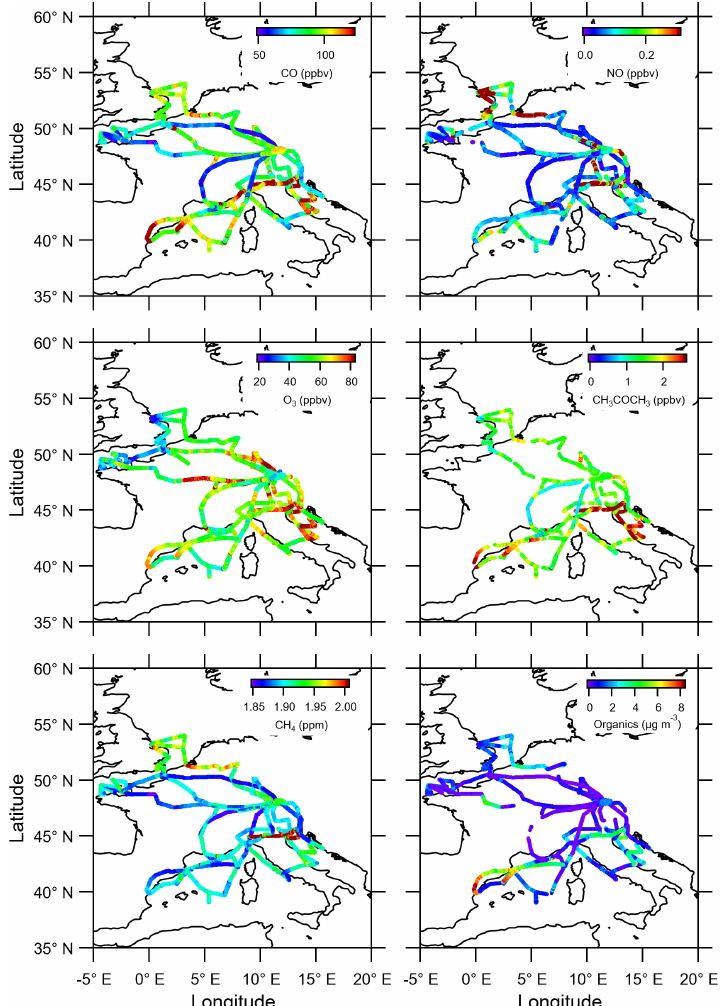
Figure 11. Mixing ratios of CO NO, O 3 , CH 3 COCH 3 , CH 4 , and organic aerosol mass concentrations measured along all EMeRGe flights in Europe. To increase colour contrast, 50ppbv has been set as lower limit for CO, and 0.3 and 80ppbv as upper limit for NO and O 3 , respectively. These limits are representative for more than 95% of all measurements. CH 4 mixing ratios are maximum values in 0 . 05 × 0 . 05 ◦ bins as in Klausner (2020). Organic aerosol mass concentrations are plotted for the original time resolution of 30s and 8µgm − 3 were set as the upper limit. Note that mixing ratios measured at different altitudes in the shuttle areas are not distinguishable in the